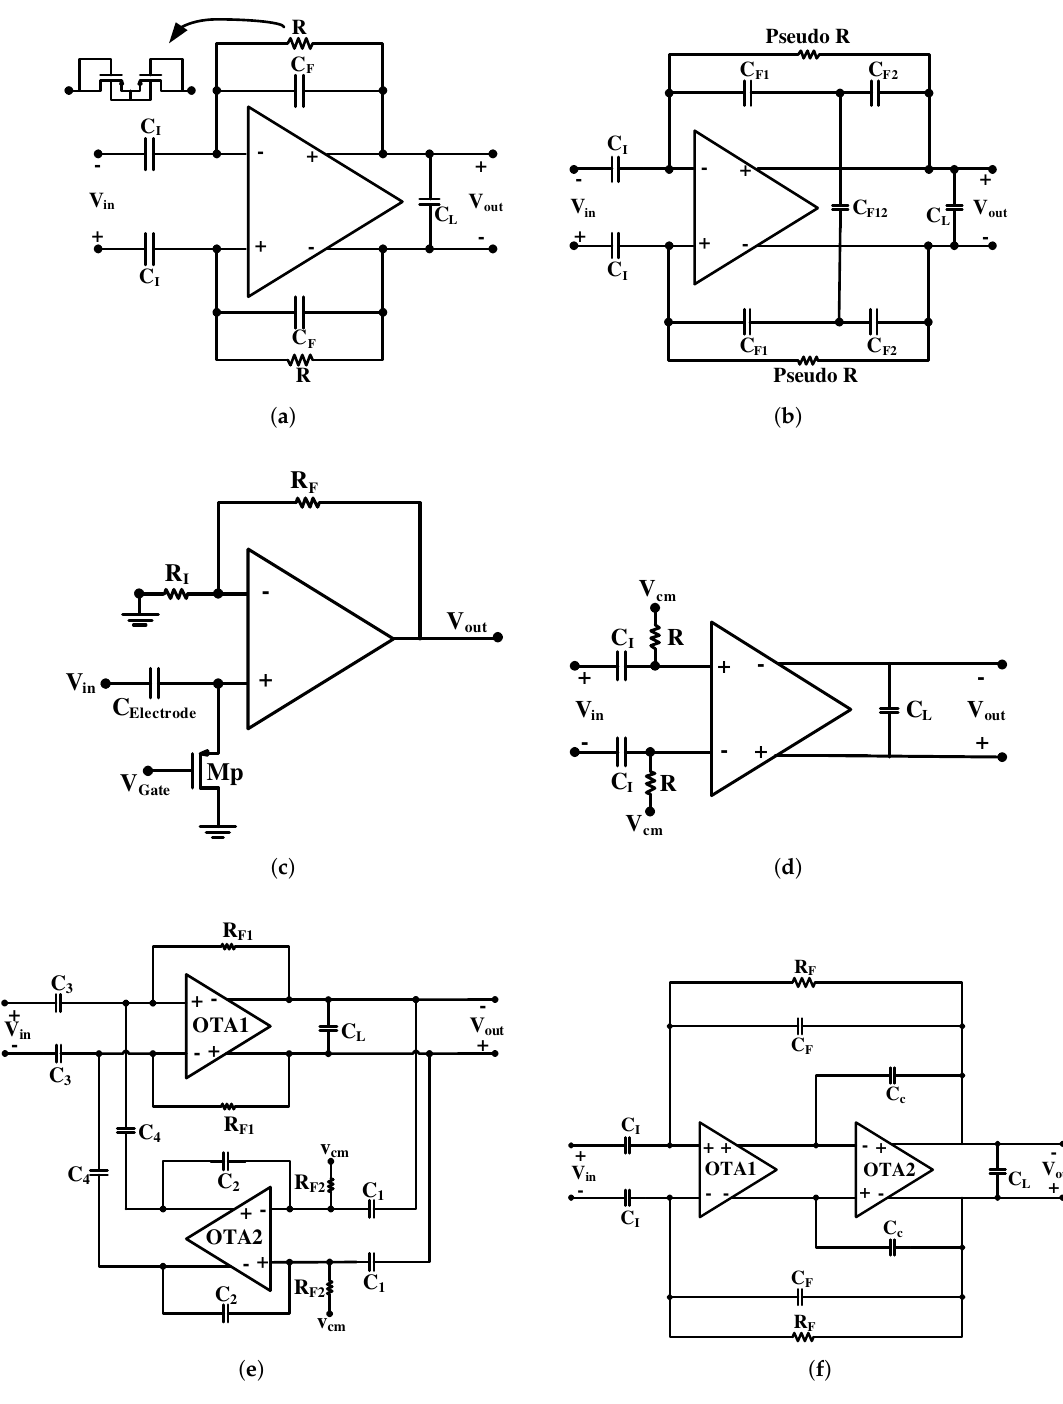
Figure 3. AC-coupled neural amplifier topologies. ( a ) Conventional capacitive-feedback network (CFN) topology. ( b ) CFN amplifier using T-capacitor feedback network topology. ( c ) AC-coupling utilizing the electrode capacitance and a resistive feedback. ( d ) Open loop network (OLN) topology. ( e )